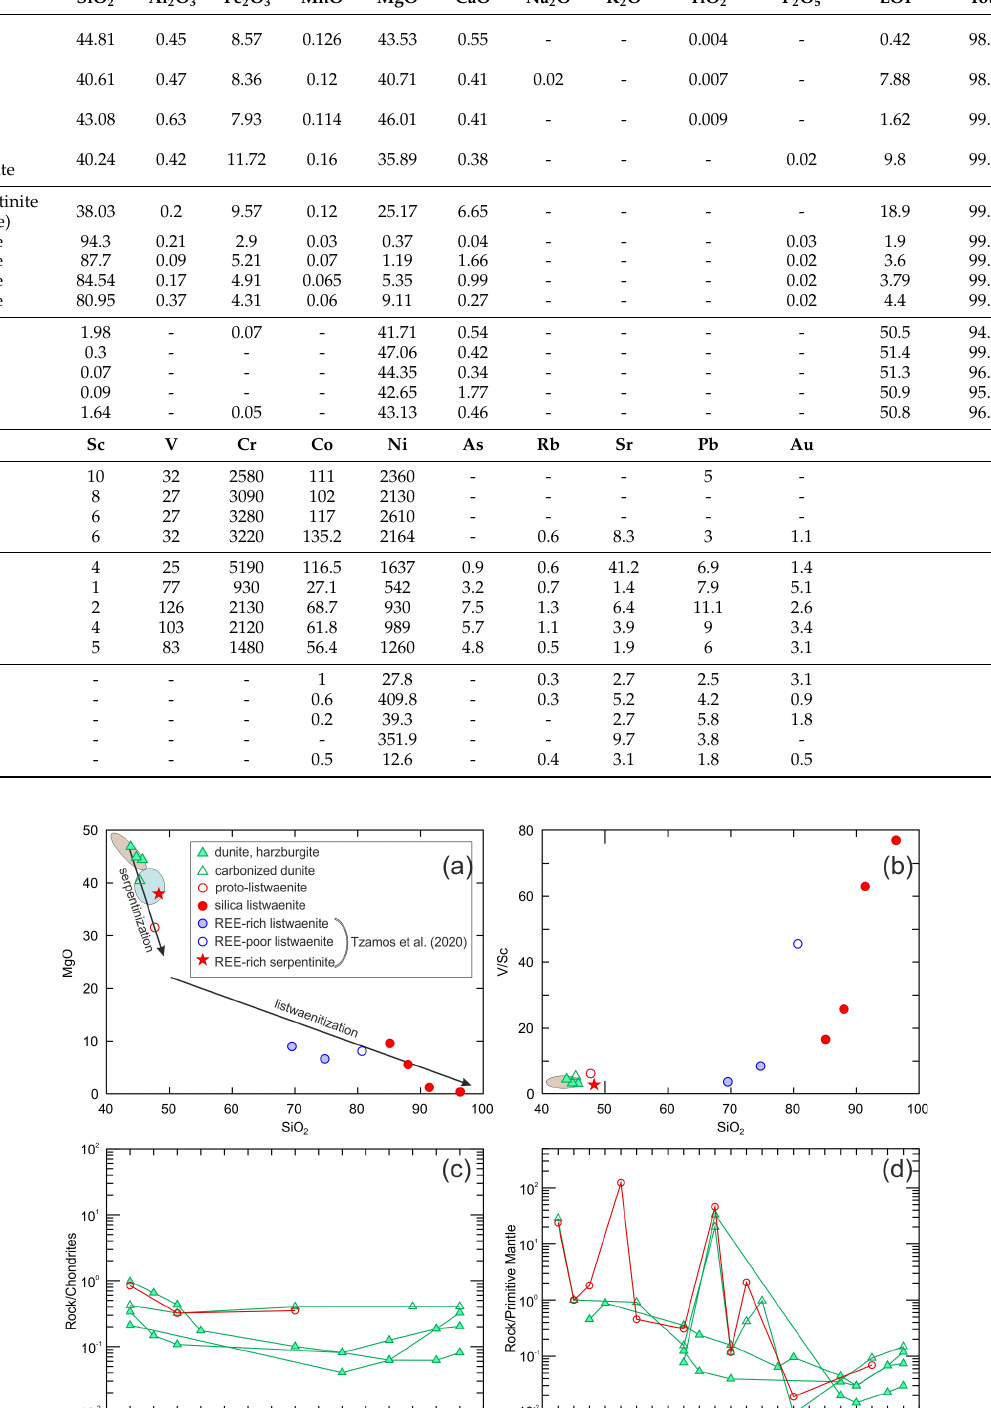
Figure 8. Geochemical diagrams ( a ) MgO vs. SiO 2 ; ( b ) V/Sc vs. SiO 2 ; ( c ) Chondrite-normalized REE patterns, after [36], of the studied unaltered and altered peridotites; ( d ) Primitive mantle-normalized multielemental patterns, after [36], of the studied unaltered and altered peridotites; ( e ) Chondrite- normalized REE patterns of the studied listwaenites and magnesites; ( f ) Primitive mantle- normalized multielemental patterns of the studied listwaenites and magnesites. Grey field peridotites reported by [16]; blue field serpentinites from Vardar derive ophiolitic remnants, reported by [38]. Serpentinized rocks from this study and other Vardar ophiolite occurrences [38] demonstrate gradual enrichment in SiO 2 and decrease of MgO contents; Iddingsitized serpentine (proto-listwaenite) consists of 38.03 wt% SiO 2 and 25.17 wt% MgO. Fe 2 O 3 concentrations are more enriched in dunite and serpentine with high LOI (7.88–18.9 wt%). However, there is a compositional gap between the serpentinites and the listwaenites, with the latter following a different trend (Figure 8a). Listwaenites are silica rich, and MgO depleted rocks ranging between 80.95–96.34 and 0.37–9.11 wt%, respectively, taking into account previous research [16], the aforementioned concentrations eventually are 69.52–96.34 wt% and 0.37–9.58 wt%, respectively. Listwaenites similar to those reported in this study, i.e., with silica contents > 80 wt% and substential amounts of red-colored mass (rusty silica, see Chapter 4.1) comprising of Fe-hydroxides and oxides, are classified as silica listwaenites (or birbirites) [7,10]. V/Sc ratios demonstrate an increase with increasing SiO 2 from protoliths and serpentinites towards the listwaenites (Figure 8b); with Sc being removed and V being introduced during listwaenitization. Cr, Co, Ni, and Zn concentrations are also being